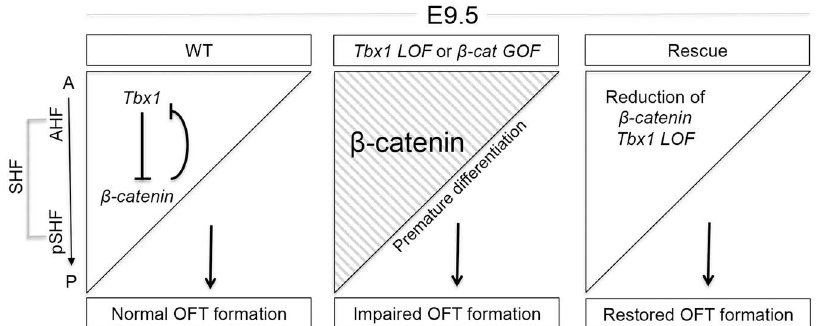
Fig 7. Model for Tbx1 and β -cateninfunction in the SHF. In the model, the trianglerepresentsthe Mef2c- AHF-Cre lineageand the Tbx1 expressionpattern, before migratinginto the heart tube at E9.5. Left panel: Tbx1 expressionis strongest in the AHF and weakest in the posterior SHF (pSHF) while Wnt/ β -catenin expressionis opposite. Left panel depicts a possibledoublenegative feedbackloop betweenthe two genesin the SHF, requiredfor normal cardiacoutflow tract (OFT) formation. Middlepanel shows increased differentiation in the AHF when Tbx1 is inactivatedor β -catenin is constitutively active in the AHF. This results in premature differentiationwithin this tissue. Right panel depicts the rescue genotypein which both allelesof Tbx1 and one alleleof β -catenin was inactivatedin the AHF. Significant rescue of heart defects was obtained. Abbreviations: A = anterior, P = posterior, OFT = outflow